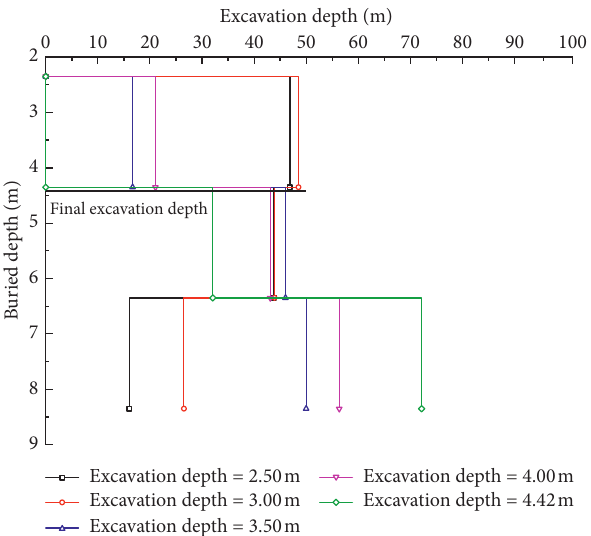
Figure 18: Relationship between the excavation depth and skin friction of the underpinning pile.